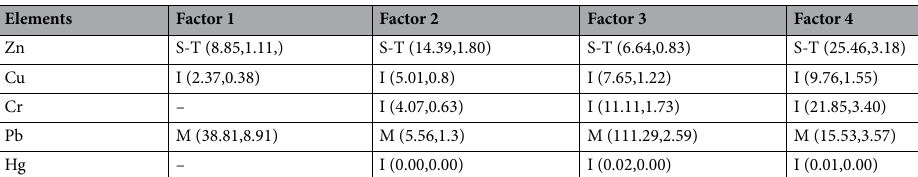
Table 4. Fitting types and parameters of the probability distribution of different HM sources. (a1, a2) in S-T defines the midpoint and scale of the student distribution, (b1, b2) in I defines the mean and scale of the logical distribution, and (c1, c2) in M defines the most likely value and scale of the maximum extreme value